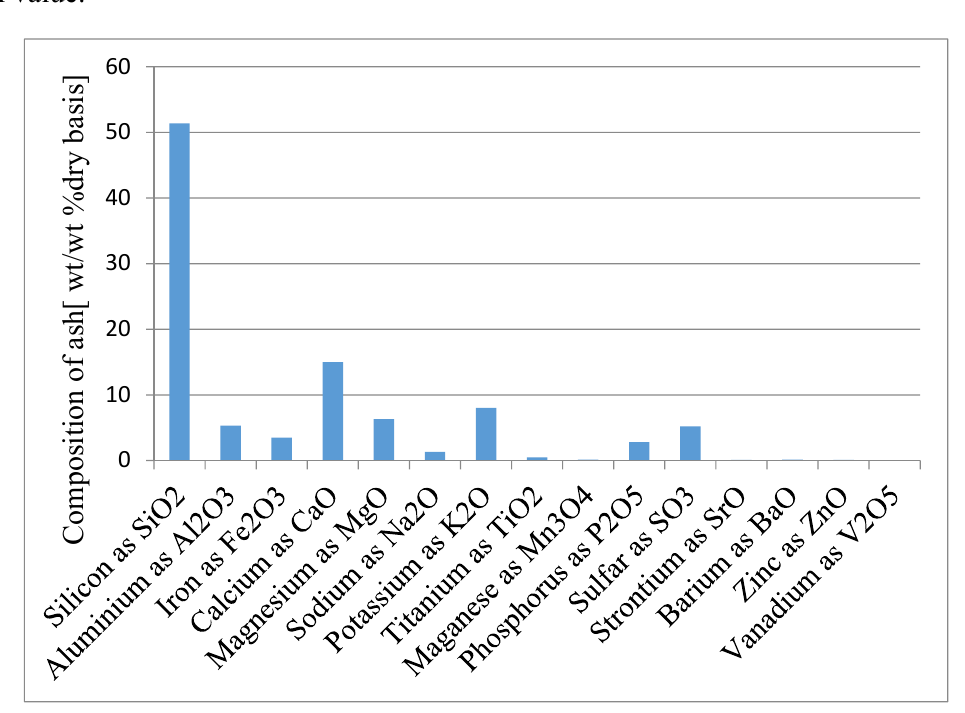
Figure 3. Green waste ash constituent